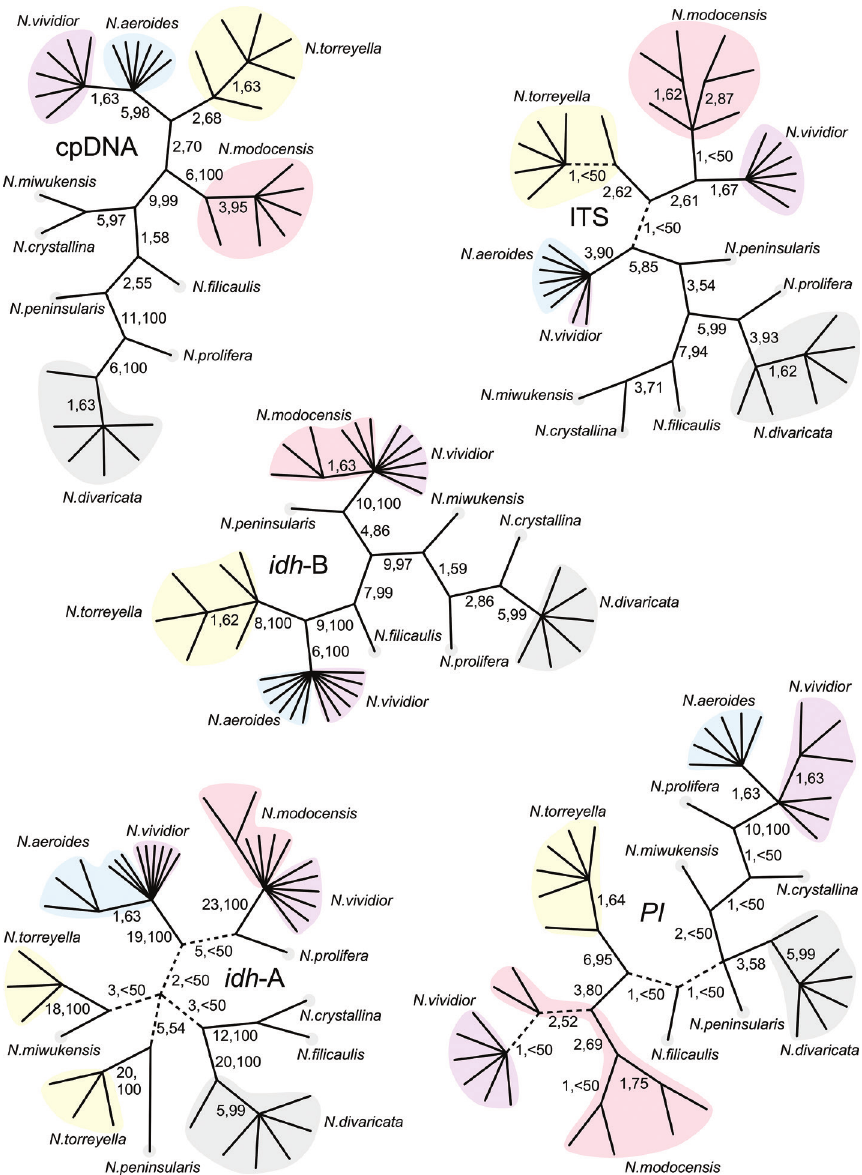
Figure 8. Representative most parsimonious, unrooted trees inferred from analysis of DNA sequence data. Base substitutions are reconstructed along interior branches, followed by bootstrap support values. Shaded regions around terminal branches circumscribe individuals of the same taxon, using colors for Navarretia vividior , N. modocensis , N. aeroides , and N. torreyella that correspond with the colors of symbols used in Fig. 4. Branches not found in all most parsimonious topologies for each region are represented by dashed lines. A Single topology inferred from concatenated cpDNA sequences B One of eight topologies inferred from nrDNA ITS sequences C Single topology inferred from nuclear idh -B sequences D One of 13 topologies inferred from nuclear idh- A sequences E One of nine topologies inferred from nuclear PI